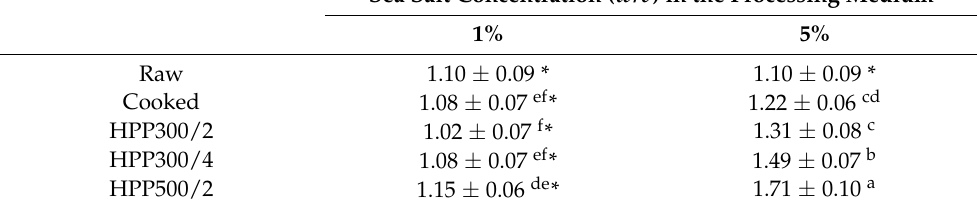
HPP500/2 1.15 ± 0.06 de * 1.71 ± 0.10 a Note. Results are expressed as mean values ( ± standard deviation). Different superscript letters indicate signif- icantly different ( p < 0.05) mean values. The symbol (*) indicates the mean values which are not significantly different ( p ≥ 0.05) from the mean value observed for the meat from raw claws. Sample codes: HPP300/2 and HPP300/4, high-pressure processed at 300 MPa for 2 and 4 min, respectively; HPP500/2, high-pressure processed at 500 MPa for 2